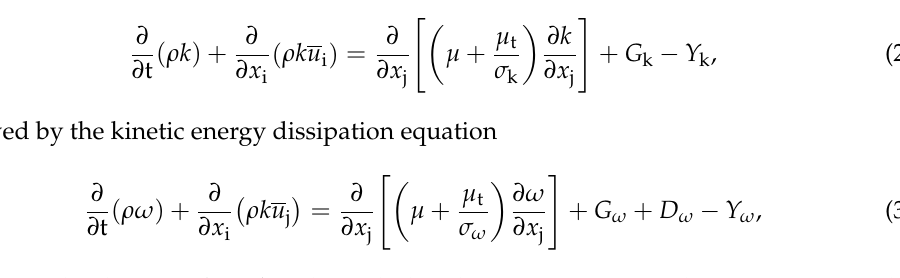
Figure 4. Grid of the computational rotation domain.